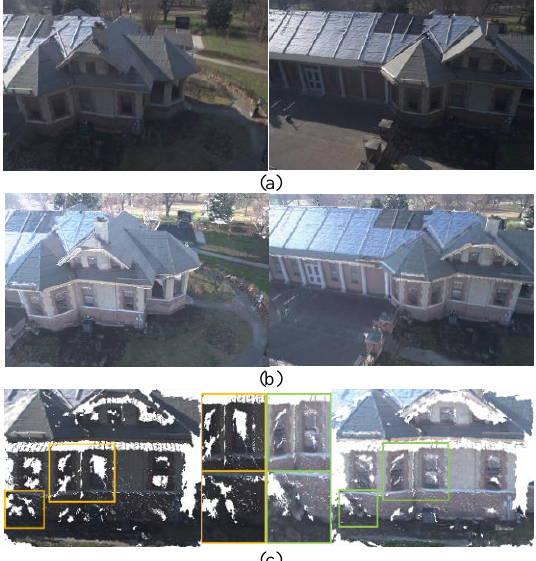
(c) Figure 16. Comparison of dense matching point clouds of origin images (a) with our albedo images (b). Left of (c) is generated from original images, right is generated from